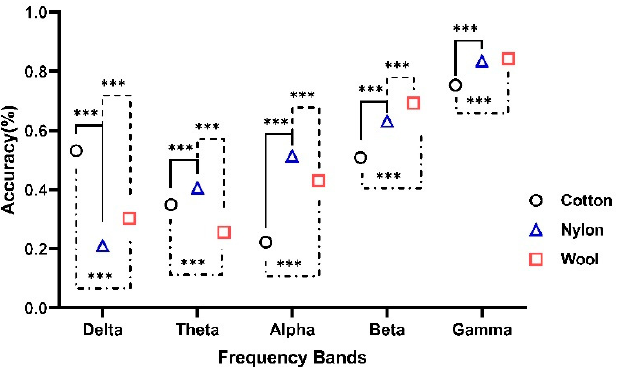
Figure 5. Comparisons of the overall classification accuracies of the SVM-ML model with respect to fabric stimulations in the delta, theta, alpha, beta, and gamma bands. The significant intergroup differences are indicated by ‘***’ ( p < 0.001, Kruskal–Wallis with Bonferroni post-hoc test). The generalized performance of the model was also evaluated by considering the arm differences during stimulations with different fabrics (Table 5). The classification accuracies of each upper-limb group during stimulations with different fabrics are not normally distributed ( p < 0.5, Shapiro–Wilk test). Significant differences in the accuracies ( p < 0.001, Kruskal–Wallis test) with respect to fabric stimulations were observed in each band, except for the SU group in the gamma band ( p > 0.05, Kruskal–Wallis test). The highest classification accuracy for each upper-limb group was achieved in the gamma band. Table 5. Accuracies of the SVM-ML model for classifying the three upper-limb groups with different fabric